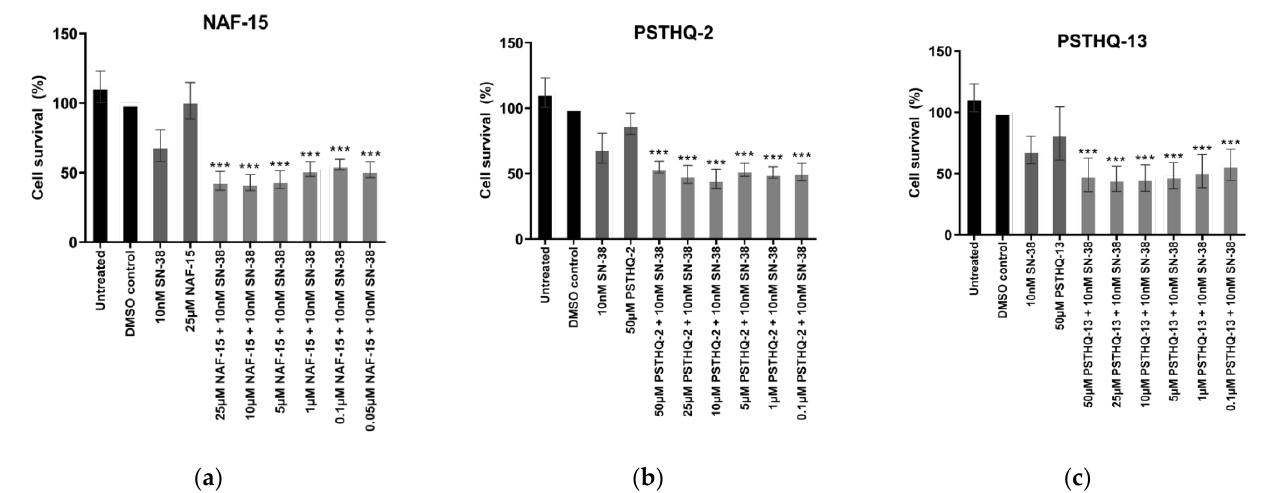
Figure 5. Cell survival after treatment with different concentrations of the TDP1 inhibitors NAF-15 ( a ), PSTHQ-2 ( b ), and PSTHQ-13 ( c ) in combination with the TOP1 poison, SN-38, for 72 h, in HeLa cells. All SN-38 containing samples contain 10 nM SN-38. DMSO control contained 0.5% DMSO, which is the same DMSO amount as in all drug-containing samples. The TDP1 inhibitors had a concentration range of 0.05 to 25 µM for NAF-15 ( a ) and 0.1 to 50 µM for PSTHQ-2 ( b ) and PSTHQ-13 ( c ). Cell survival was measured by using PrestoBlue. All data were normalized to DMSO control. *** Represents a p -value < 0.001 compared to TDP1 inhibitor or SN-38 alone.